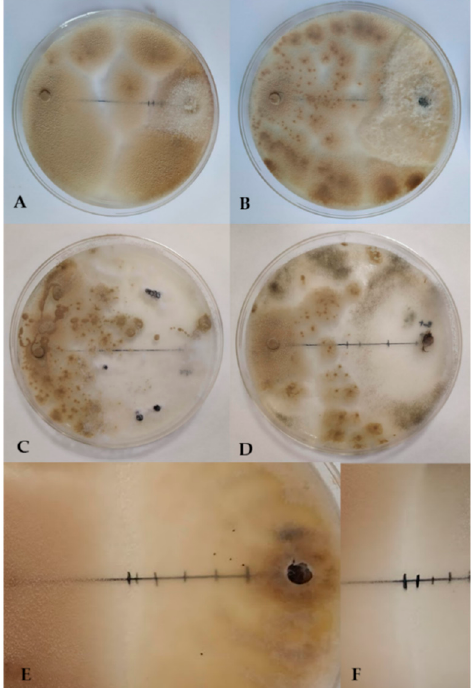
Figure 4. In vitro antagonistic effects of P. variotii on F. solani ( A ), M. melonis ( B ), S. sclerotiorum ( C ), and B. cinerea ( D ) in 9 cm Petri dishes. Inhibition zone between P. variotii and the phytopathogens M. melonis ( E ) and F. solani ( F ) (Images 75% increased).